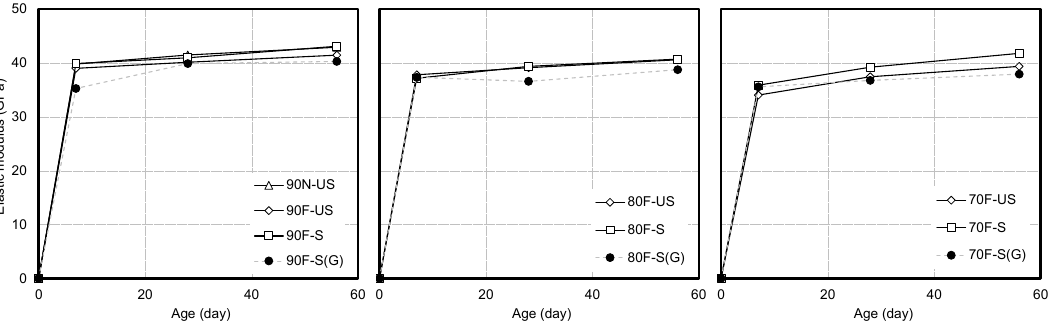
Figure 5. Compressive strength of high-strength concrete based on limestone and granite.